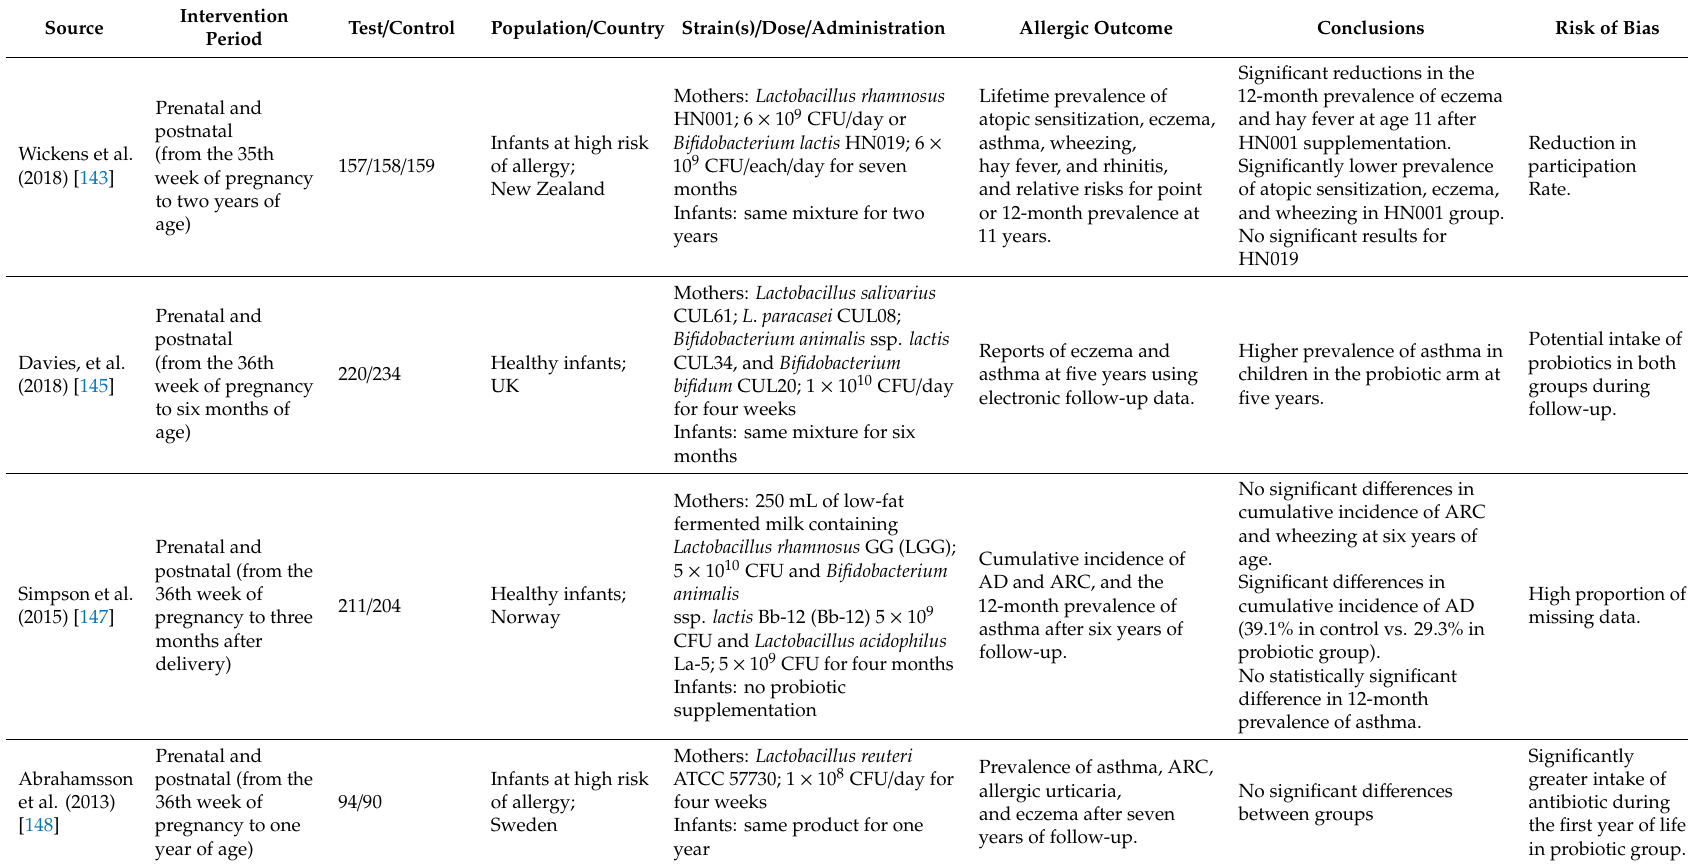
Table 4. Studies based on the use of probiotics during prenatal and pre-postnatal period for the prevention of asthma, wheezing, and